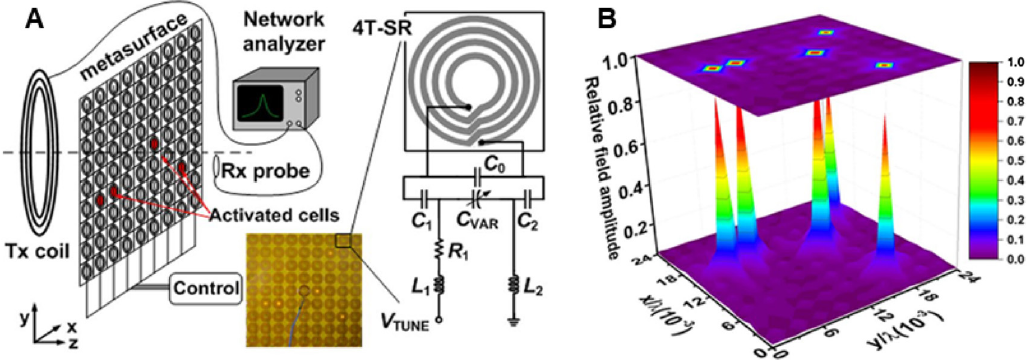
Figure 8: Active NFF